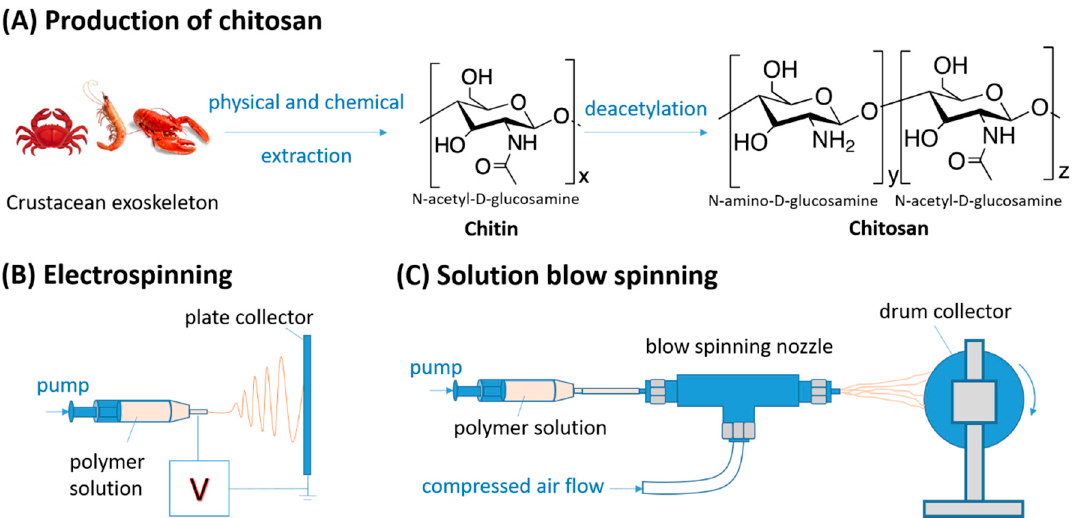
Figure 1. ( A ) The production of chitosan: Chitosan is made by deacetylation of chitin extracted from crustacean exoskeleton. Chitosan nanofibers are commonly fabricated by ( B ) electrospinning or ( C ) solution blow spinning, usually from chitosan dissolved in acetic acid. The principle of electrospinning is the induction of a liquid jet from a syringe nozzle using a high voltage, while solution blow spinning uses a high-pressure inert gas as a driving force. The solvent evaporates at the nozzle, and the polymer chains are stretched and travel the tip-to-collector distance, where the solidified nanofibers accumulate on the collectors.